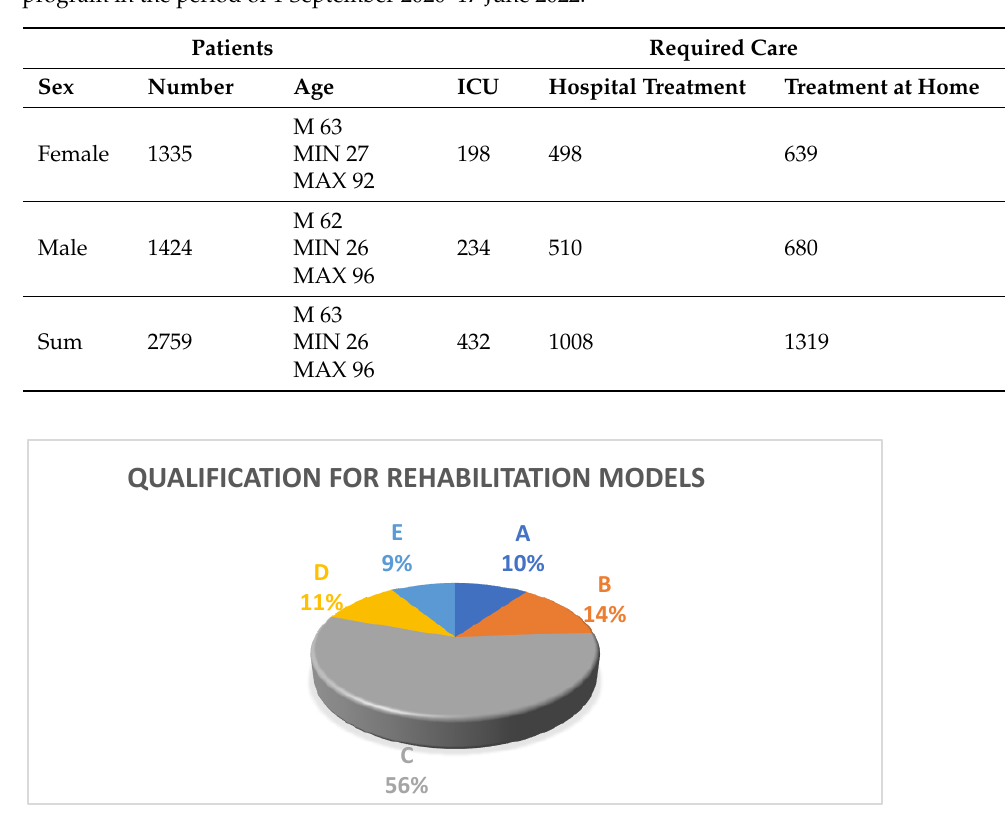
Table 1. Brief characterization of the patients participating in the post-COVID-19 rehabilitation